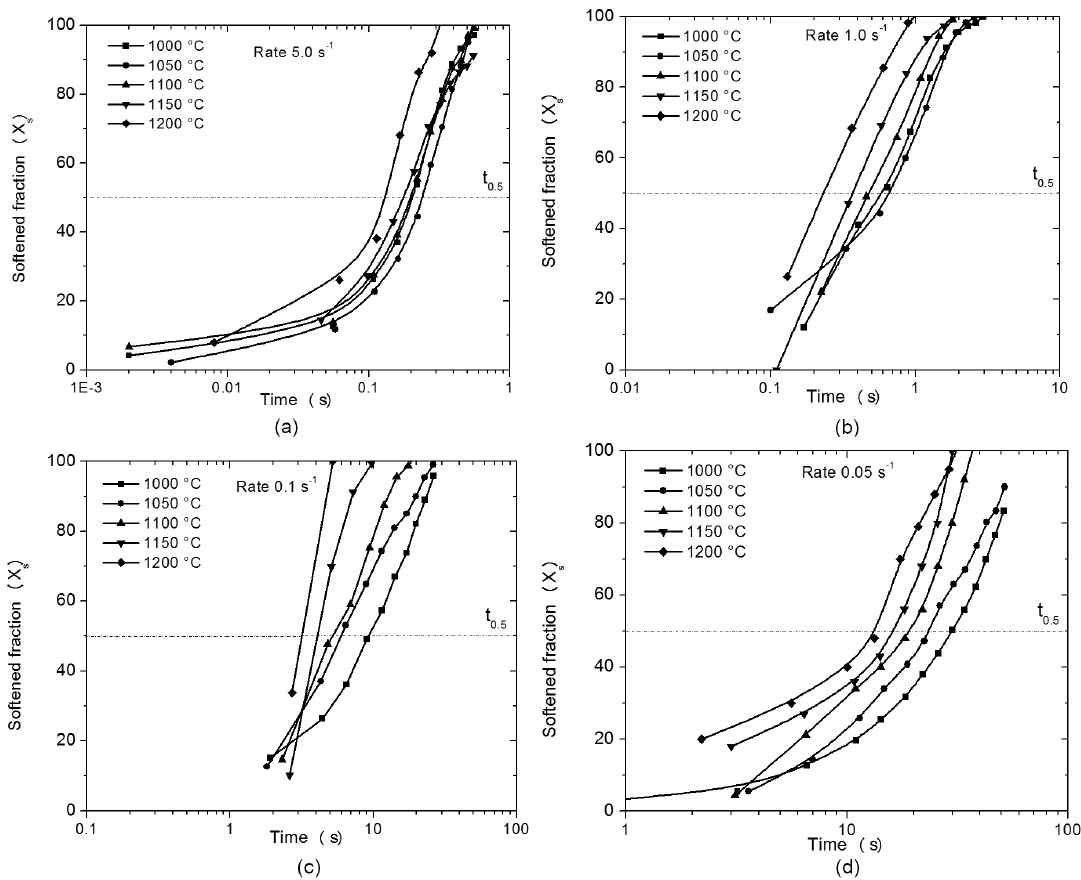
Figure 5. Evolution of softened fraction (Xs) vs. time (s) for the ISO 5832-9 to different strain rates: (a) 5.0 s –1 , (b) 1.0 s –1 , and (c) 0.1 s –1 , (d) 0.05 s –1